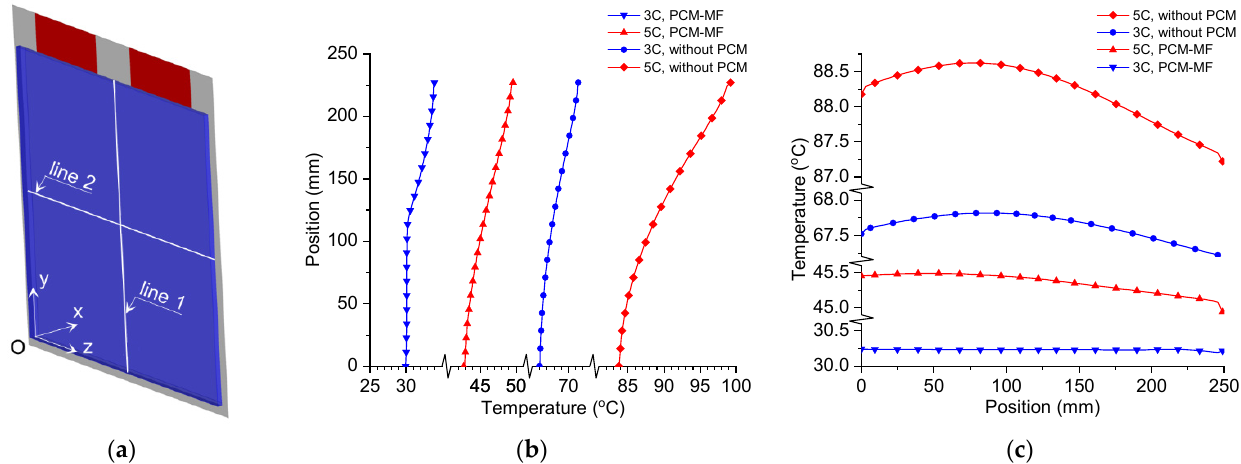
Figure 15. ( a ) Temperature monitoring lines. ( b ) The temperature distribution at line 1. ( c ) The temperature distribution at line 2.